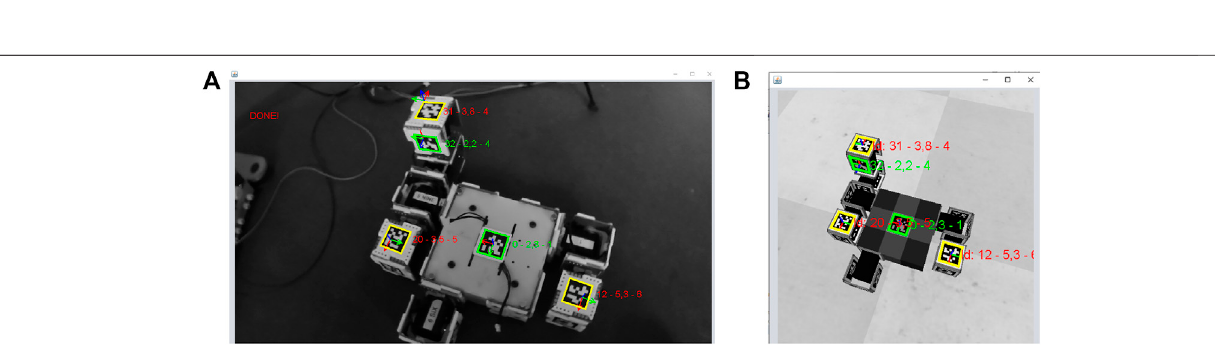
Frontiers in Robotics and AI |